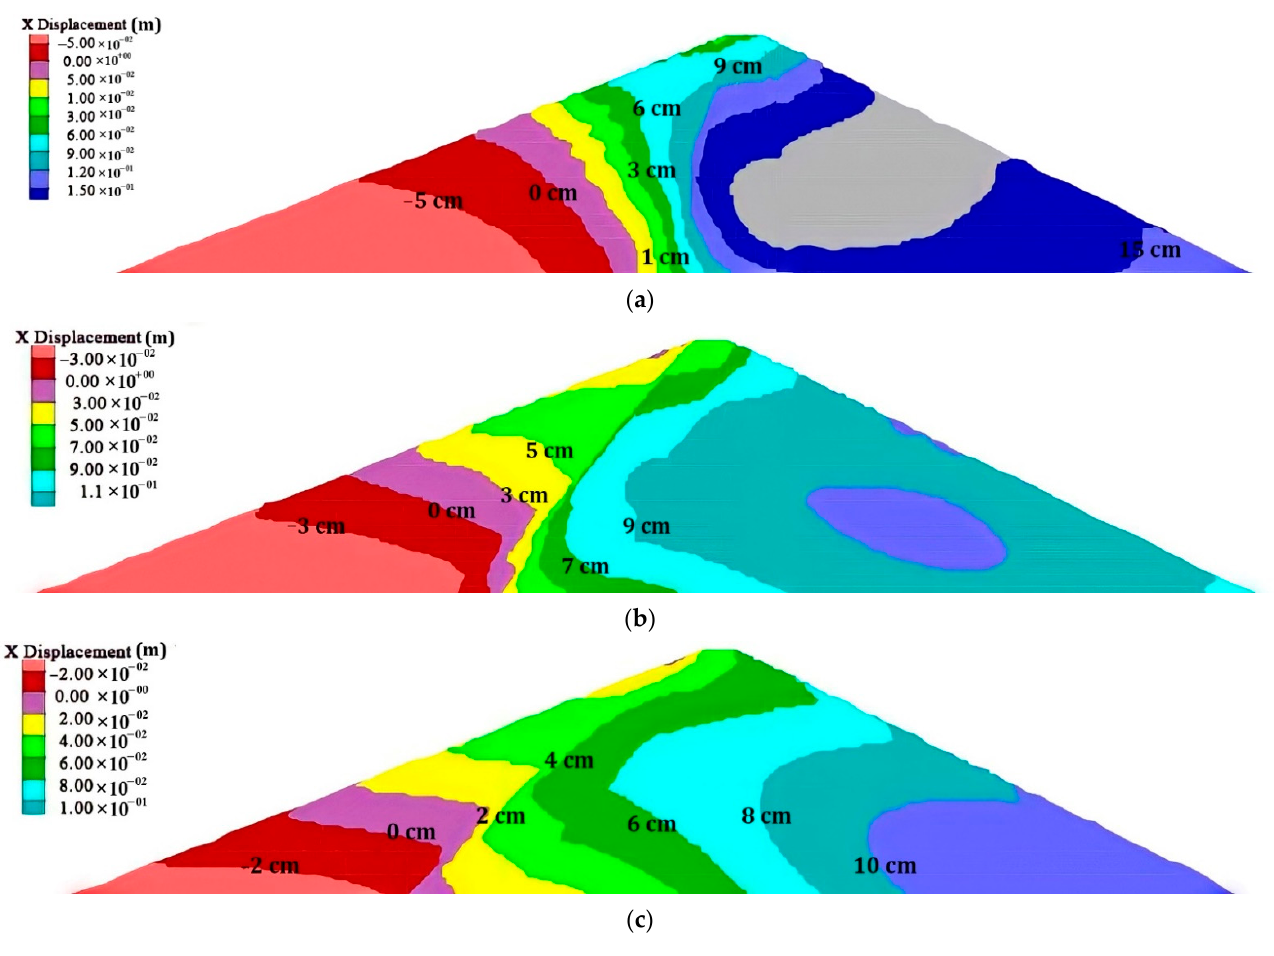
Figure 5. Horizontal displacement contours at impounding stage ( a ) 90° core, ( b ) 60° core and ( c ) 45° core.